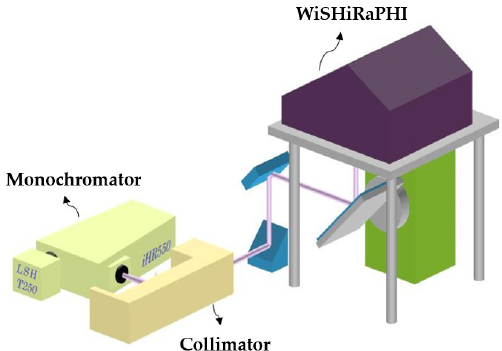
Figure 7. Full-field of view (FOV)-covered spectral calibration facility.